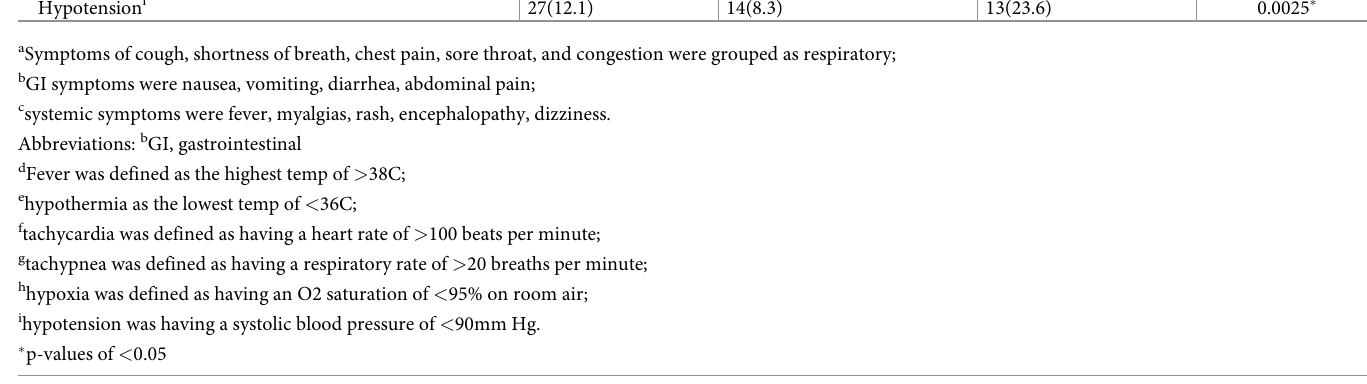
versus 14%; p < 0.001); a higher proportion of patients with non-severe disease had normal chest x-rays (23% versus 9%; p = 0.02) [Table 7]. In multivariate logistic regression, progres- sion to severe disease was associated with respiratory symptoms (aOR 7.0, 95% CI: 1.4–34.1),